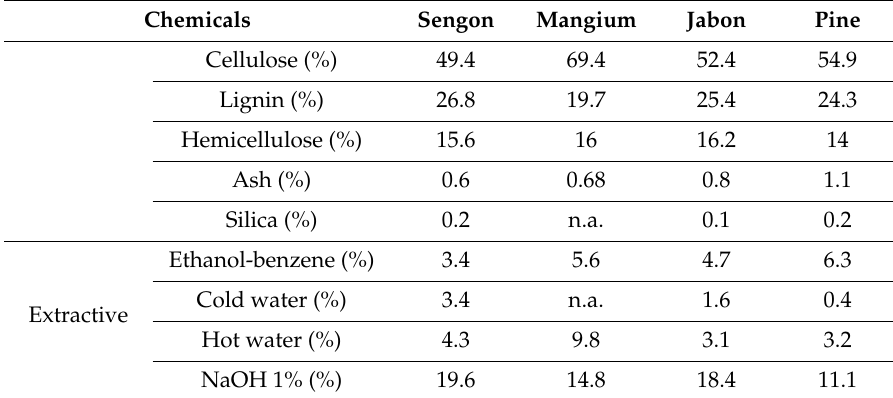
Table 1. Chemical contents of four species used in this work